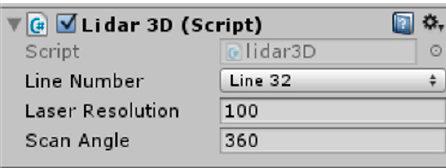
Figure 7. Program page of the 3D LiDAR script.